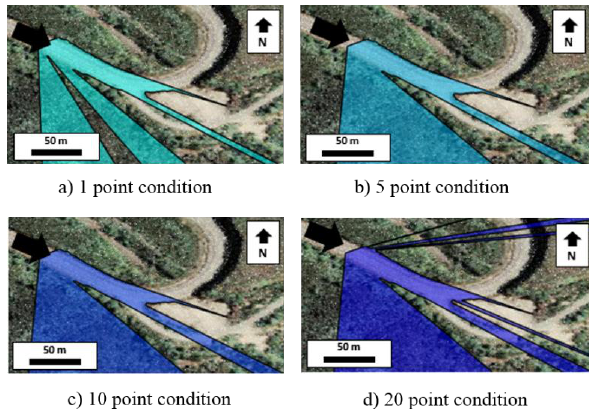
Figure 3. Plane projection of the occlusion points and area obtained. Figure 5. Different conditions in the occlusion for the algorithm. Visibility up to 150 m is considered. Black arrow indicates the direction and position of the car.